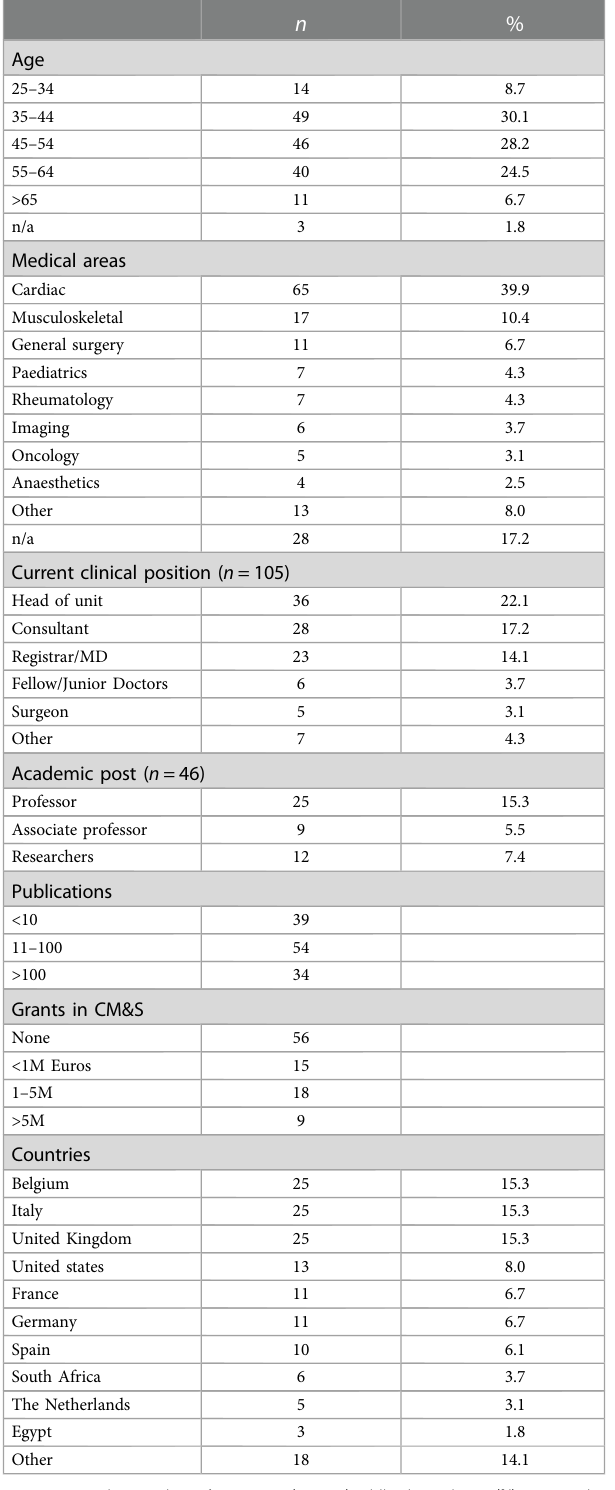
TABLE 1 Demographic characteristics of the survey respondents ( N